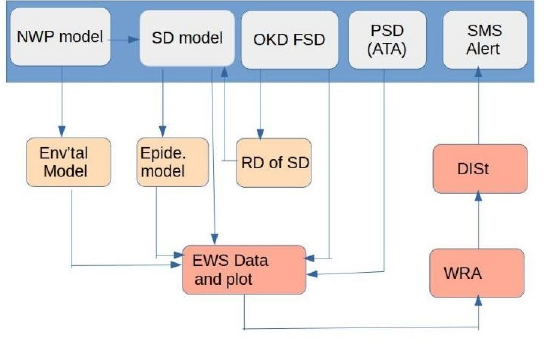
Figure 1. Early wheat rust warning system